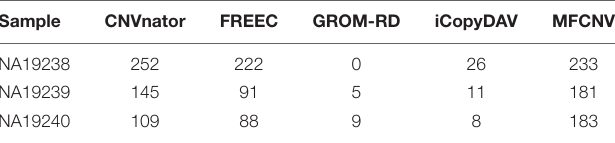
TABLE 2 | Comparison of the number of detected copy number variations between MFCNV and the four peer methods on real samples. Sample